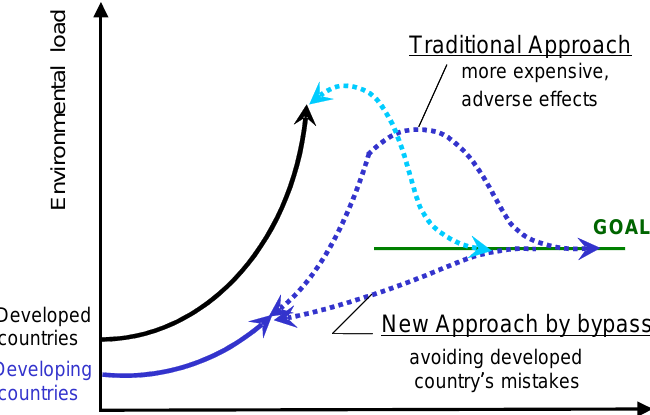
Figure 13. Illustration of approaches towards